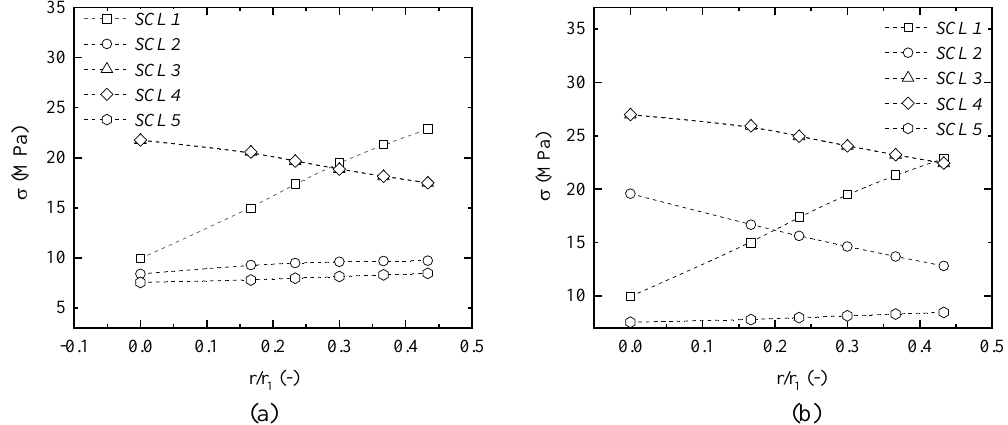
Figure 14. ( a ) Stress intensity along the horizontal line cold-to-cold channel; and ( b ) stress intensity along the vertical line hot-to-cold channel.